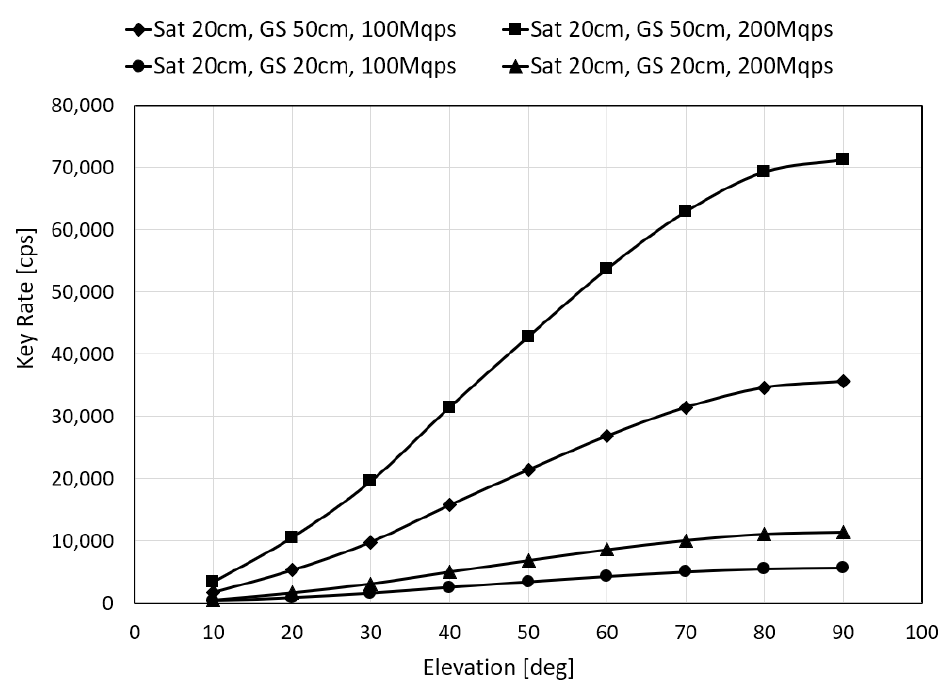
Figure 12. Key rate versus elevation angle for different optic sizes of satellite and ground station and quantum generation rate (the orbit altitude is set to 600 km).